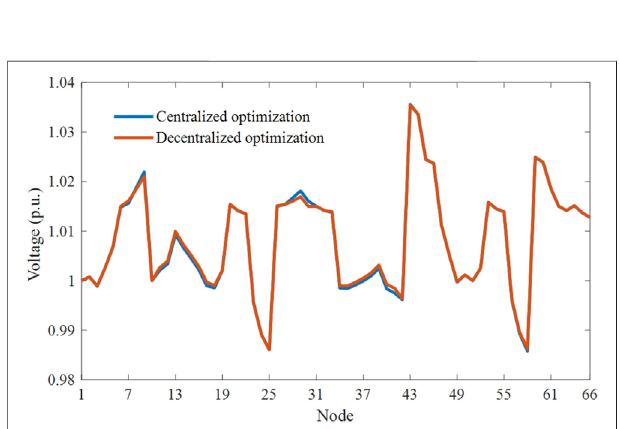
FIGURE11| Voltagepro fi